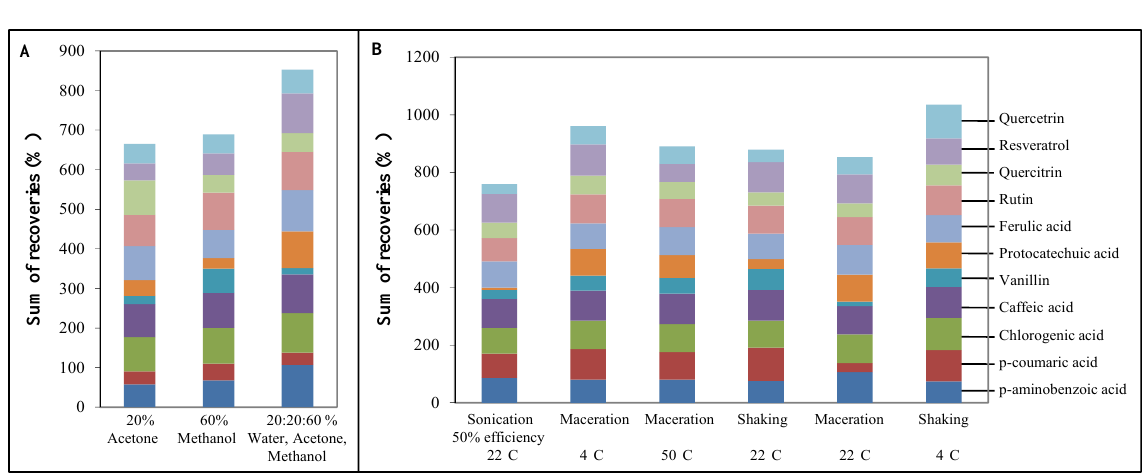
Figure 4. (a) Sum of recoveries for three various extraction solvents (b) Sum of recoveries for six various conditions (e.g., maceration 22 °C as